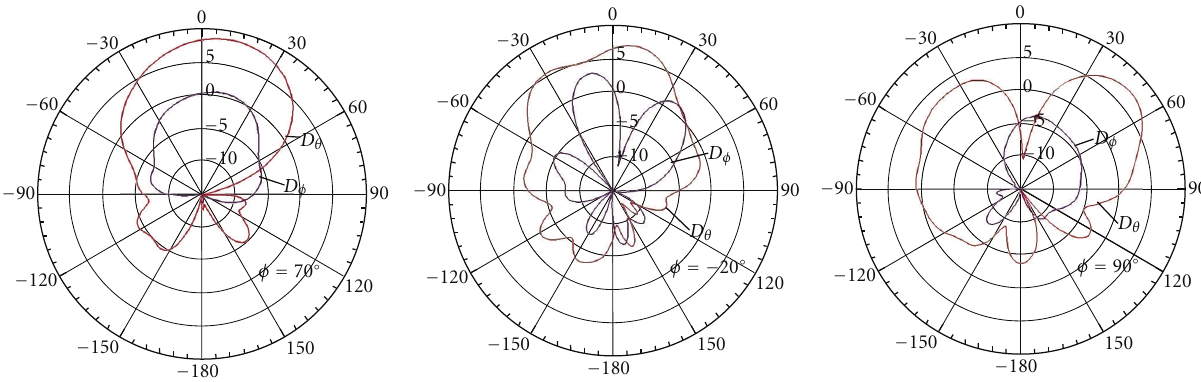
Figure 5: Plots of directivity D (dB) versus theta for the three radiation modes. Each plot is taken at the phi cut containing maximum total directivity. The three modes are mutually orthogonal over the entire sphere.